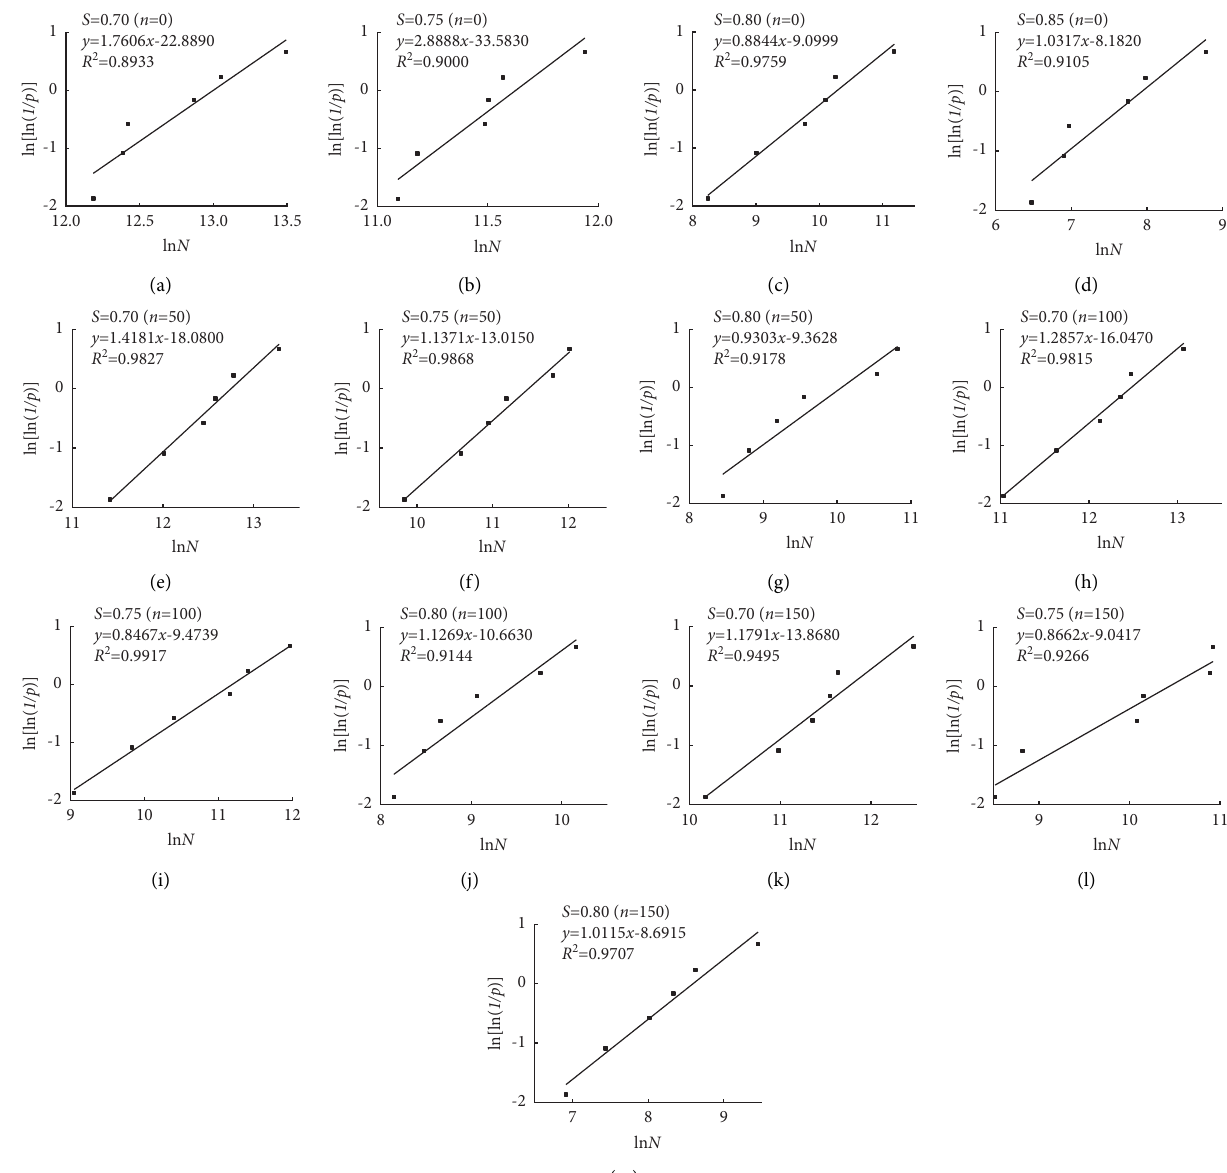
Figure 8: Two-parameter Weibull distribution test of the fatigue life of AASC. (a) S � 0.70 ( n � 0), y � 1.7606 x − 22.8890, R 2 � 0.8933; (b) S � 0.75 ( n � 0), y � 2.8888 x − 33.5830, R 2 � 0.9000; (c) S � 0.80 ( n � 0), y � 0.8844 x − 9.0999, R 2 � 0.9759; (d) S � 0.85 ( n � 0), y � 1.0317 x − 8.1820, R 2 � 0.9105; (e) S � 0.70 ( n � 50), y � 1.4181 x − 18.0800, R 2 � 0.9827; (f) S � 0.75 ( n � 50), y � 1.1371 x − 13.0150, R 2 � 0.9868; (g) S � 0.80 ( n � 50), y � 0.9303 x − 9.3628, R 2 � 0.9178; (h) S � 0.70 ( n � 100), y � 1.2857 x − 16.0470, R 2 � 0.9815; (i) S � 0.75 ( n � 100), y � 0.8467 x − 9.4739, R 2 � 0.9917; (j) S � 0.80 ( n � 100), y � 1.1269 x − 10.6630, R 2 � 0.9144; (k) S � 0.70 ( n � 150), y � 1.1791 x − 13.8680, R 2 � 0.9495; (l) S � 0.75 ( n � 150), y � 0.8662 x − 9.0417, R 2 � 0.9266; (m) S � 0.80 ( n � 150), y � 1.0115 x − 8.6915, R 2 �